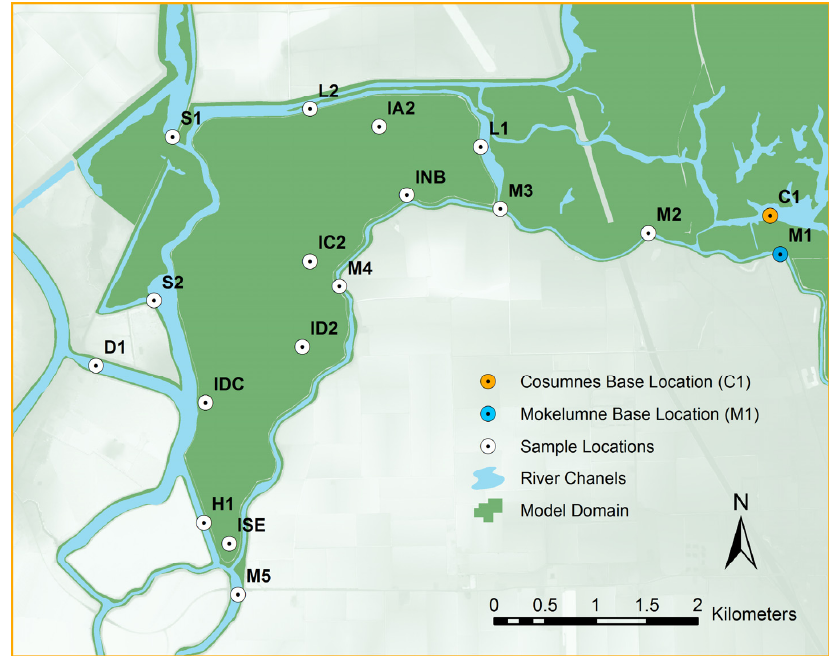
Figure 2. Study area showing isotope sample locations in white, with the Cosumnes and Mokelumne Base locations shown in orange and blue, respectively.